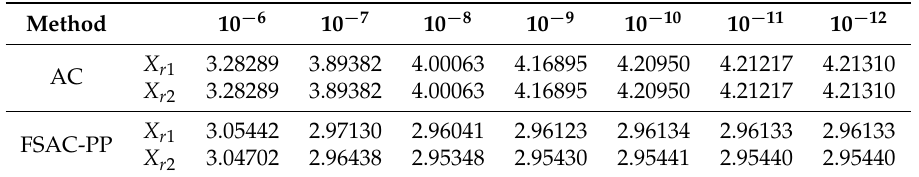
Table 2. Convergence study for different level of convergence at a Reynolds number of Re = 30 based on the reattachment length X r 1 and X r 2 at the upper and lower